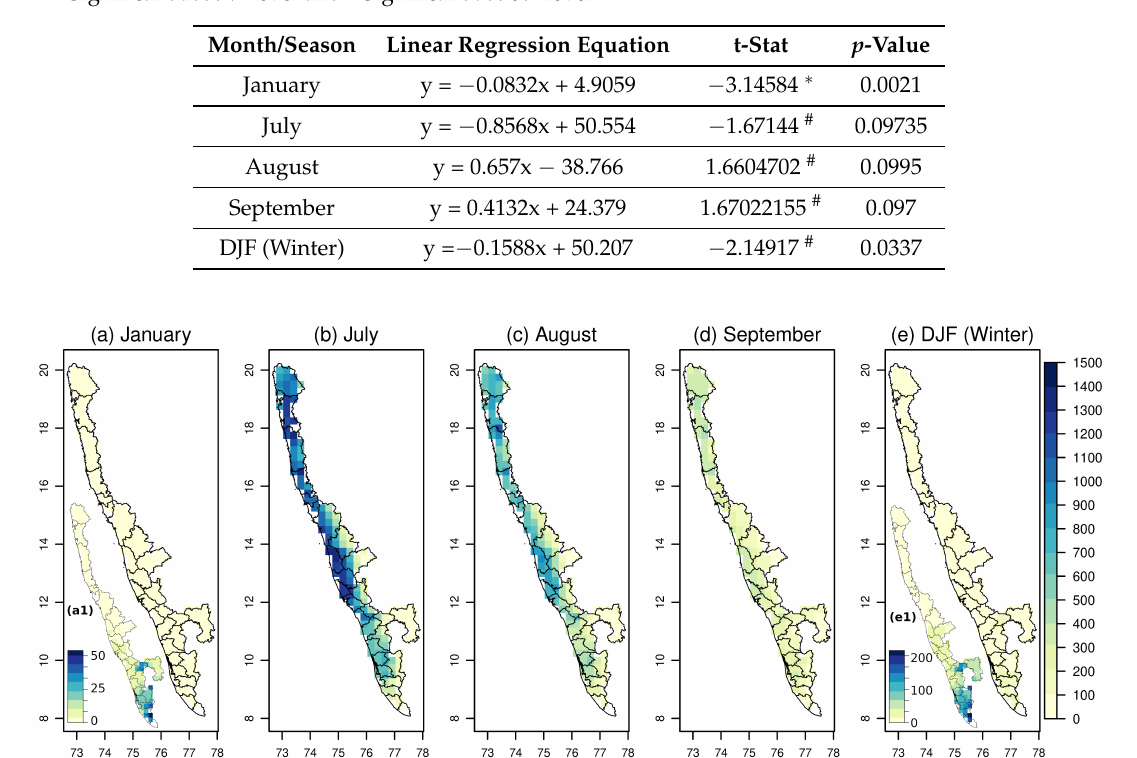
Table 3. The significant results obtained using linear regression. t-stat and their level of significance. ∗ Significant at 99% level and # Significant at 90% level.